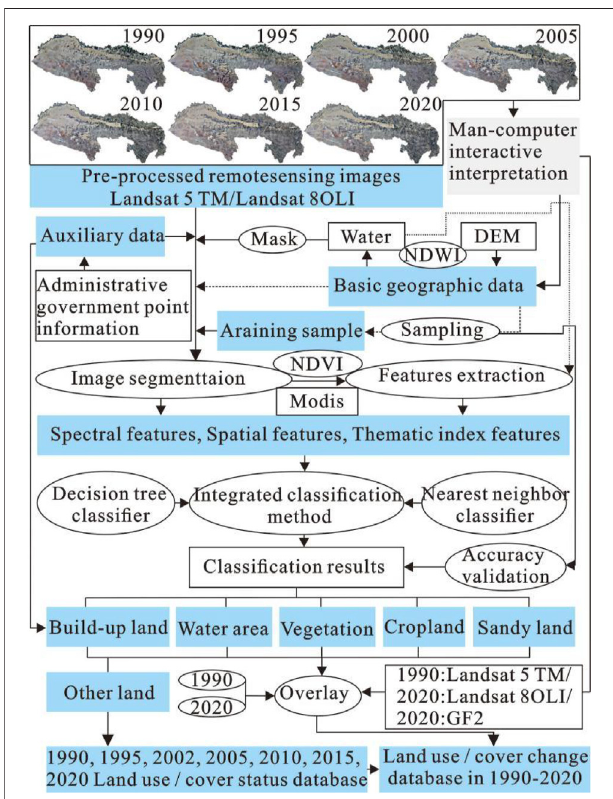
FIGURE 3 | Land use/cover change information extraction technology